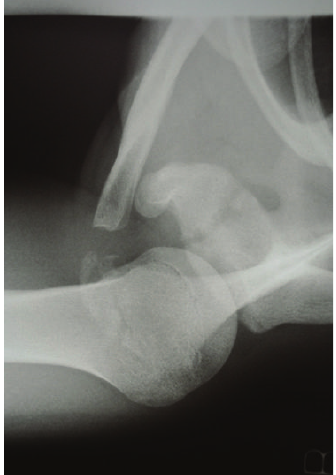
Figure 3: Case A: axillary radiograph at 9 weeks post injury.